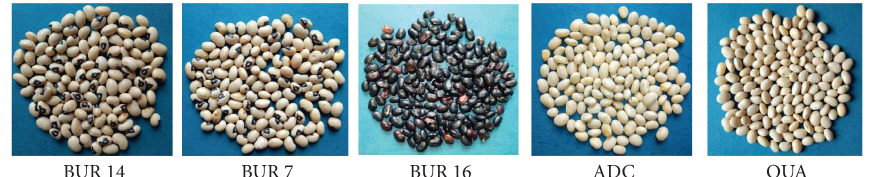
Figure 1: Seed of selected Kersting’s groundnut